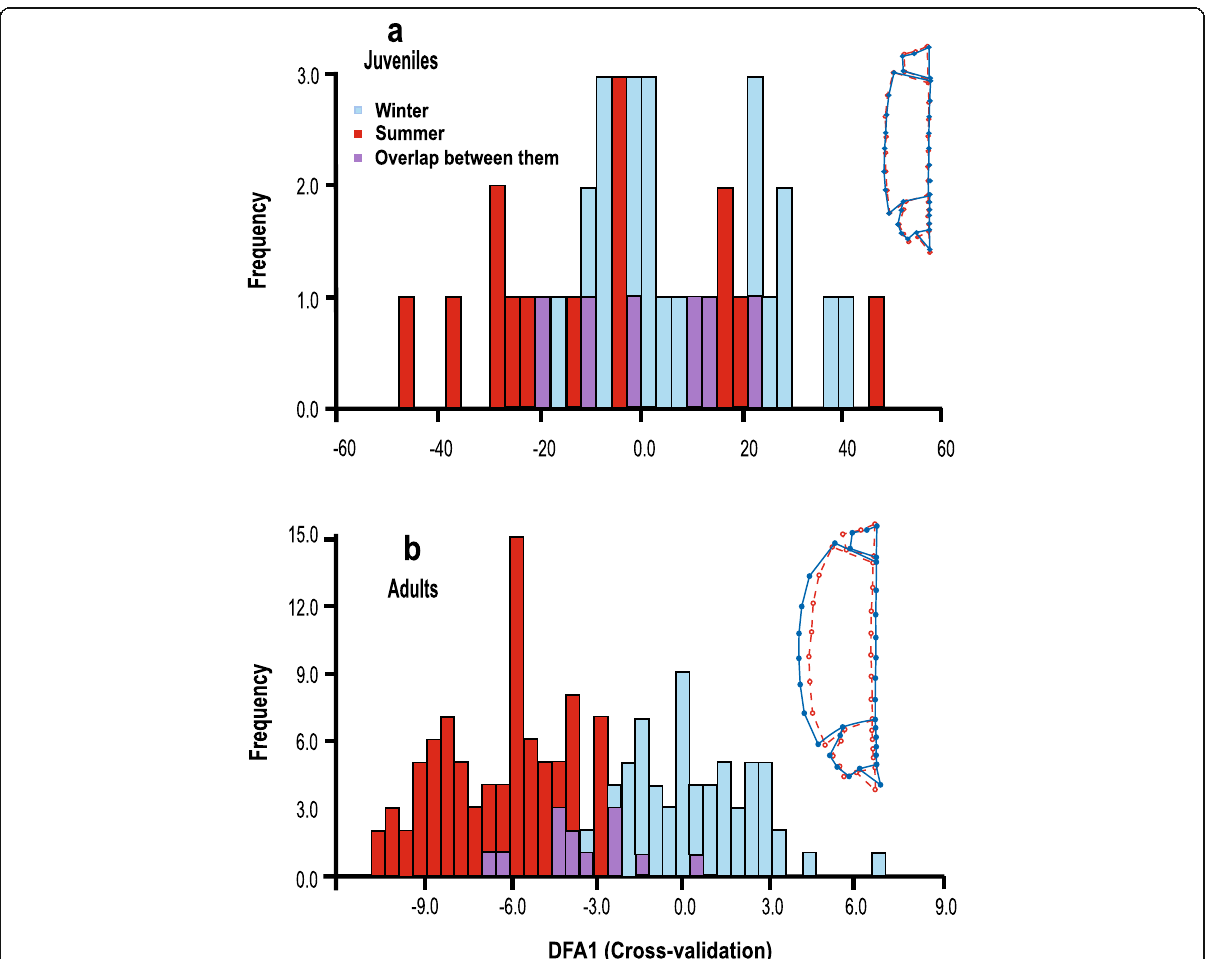
Fig. 4 Frequency histograms of discriminant analysis showing the effect of seasons on the body shape of P. pruinosus for juveniles ( a ) and adults ( b ). Note the body shape overlaps between two studied seasons for juveniles and adults. The wireframe drawings beside each histogram represent the mean shape deformation for the winter and summer